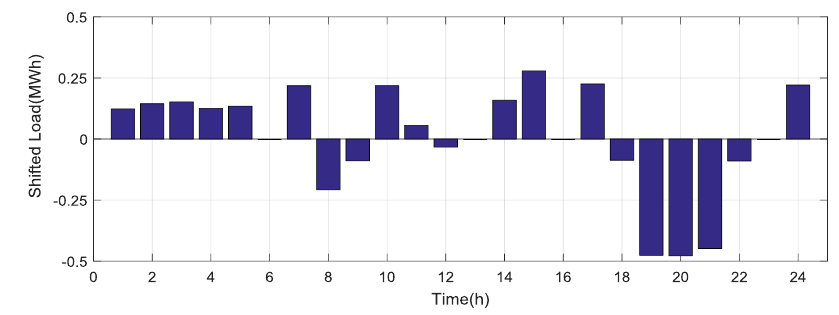
Figure 7. Shifted load demand at second-stage operation.